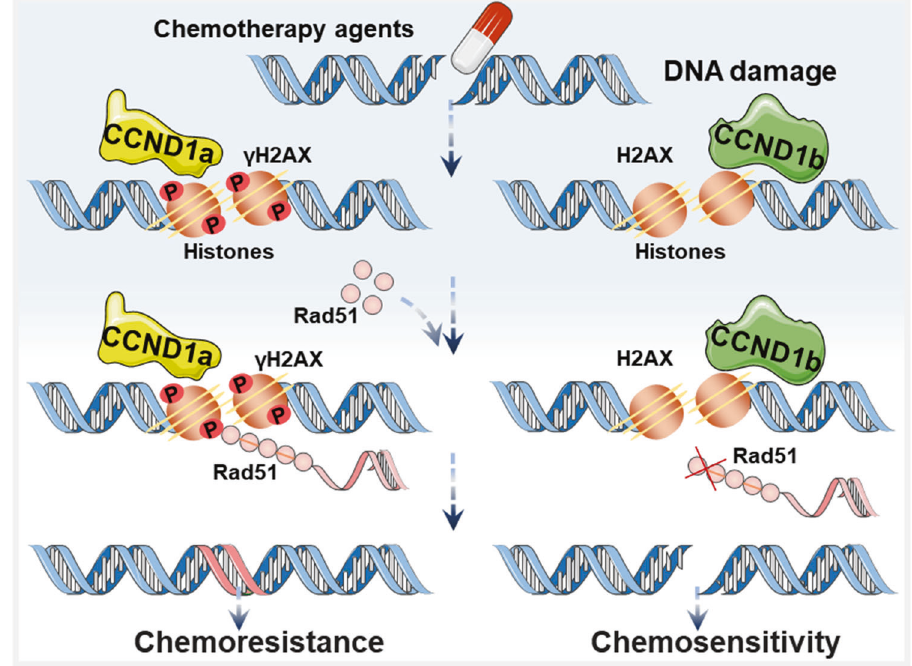
Fig. 5 CCND1 isoforms can regulate resistance to DNA damage therapy by inducing DNA damage response in cancer. CCND1a increased the phosphorylation of γ H2AX induced by chemotherapy agents and recruited Rad51 to local chromatin in response to DNA damage, leading to chemoresistance. CCND1b failed to recruit Rad51 even in response to DNA damage, resulting in